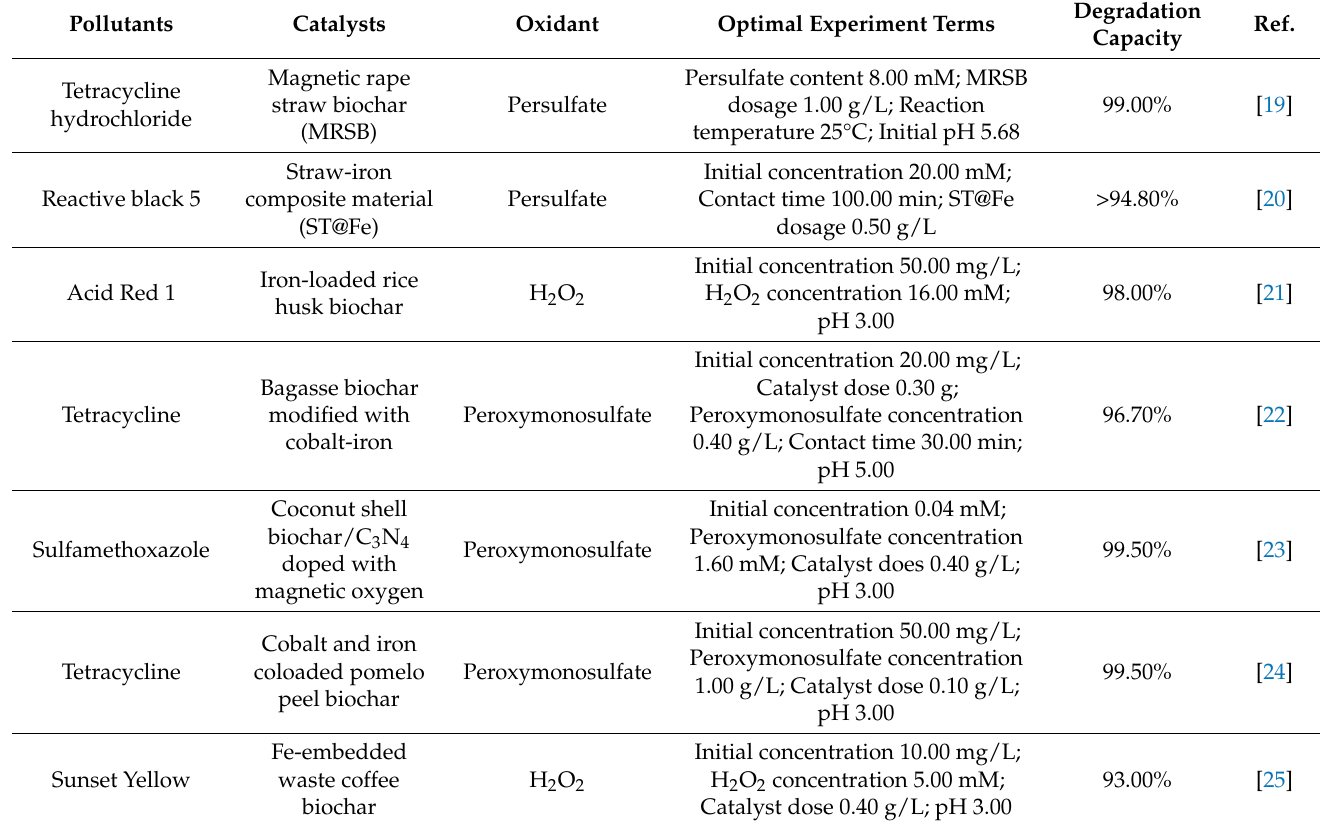
Table 1. Plant-based material activated different oxidant for the degradation of various emerging organic